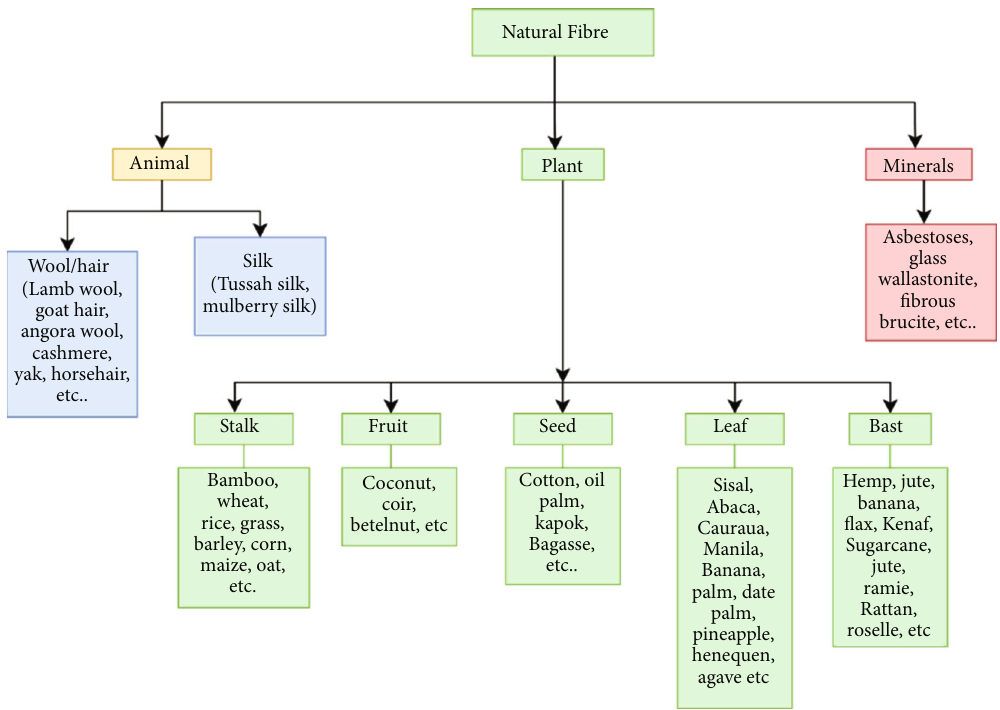
Figure 2: Types of natural fi Table 2. The proportion of chemical components in fi bre is (that degrades its bonding nature), such as hemicellulose, in fl uenced by plant tissue location and its growth rate [19]. lignin, pectin, and waxes in it. To eliminate that, some pre- Even though it has all the needed constituents for binding treatment technique was equipped with additional con- with polymer matrix, it also has non-cellulosic substituents trolled factors [31].